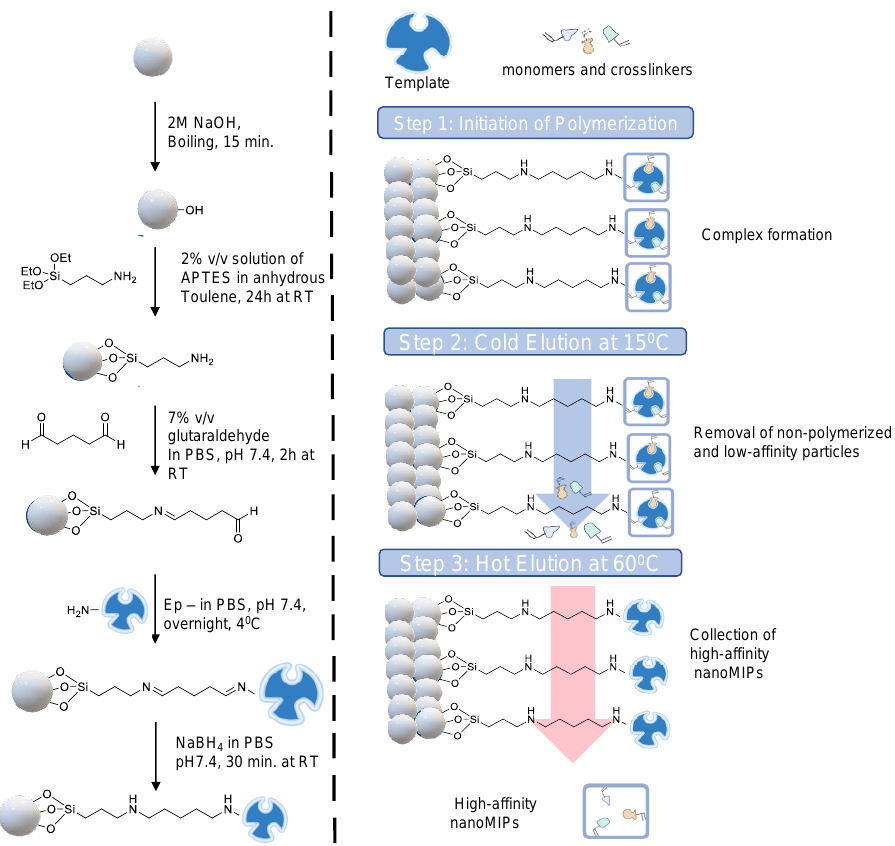
Scheme 1. Schematic representation of epitope-template immobilization on glass beads as solid support (left) and three-step solid-phase synthesis (right).